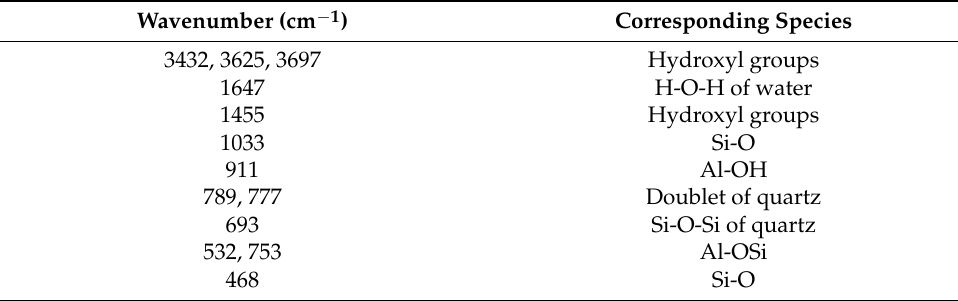
Table 2. The principal IR bands and their corresponding species of raw and modified